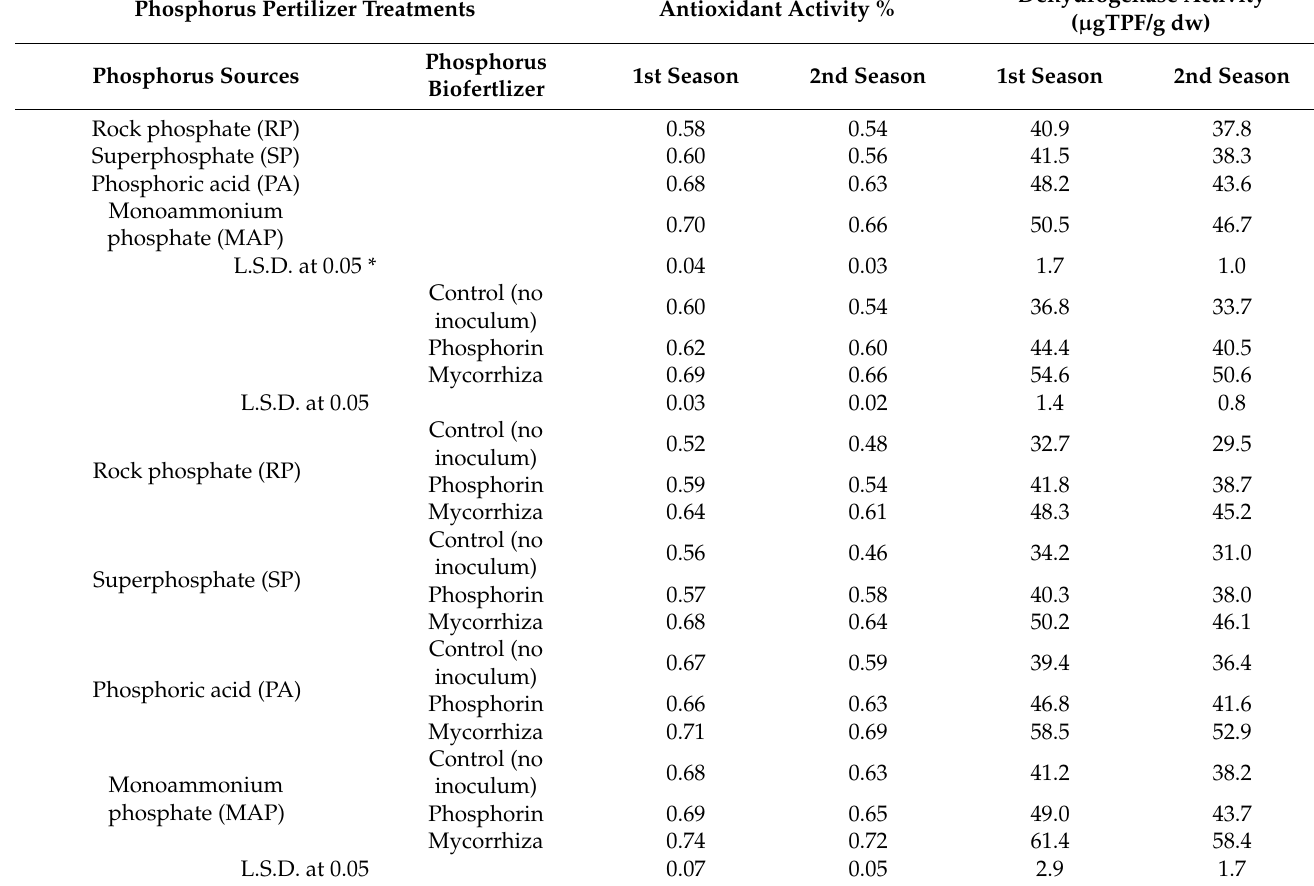
Table 9. The effect of phosphorus sources and biofertilizer application on antioxidant and dehydrogenase activity of broccoli heads during the 2018 (1st) and 2019 (2nd) seasons. Phosphorus Pertilizer Treatments Antioxidant Activity